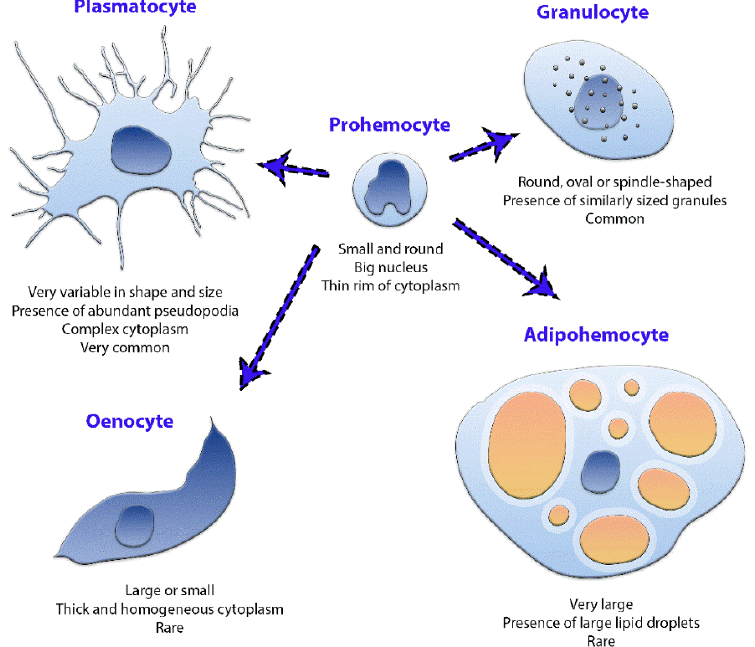
Figure 8. Schematic representation of the main features of each hemocyte type found in the hemolymph of fifth instar nymphs of Dipetalogaster maxima . The dashed arrows refer to the possibility that all cell types arise from the